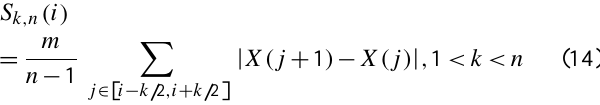
Figure 2. (a) A synthetic nhBm s(z) corresponding to a simulated multi-layer geological6 model. (b) Local changes of the Hurst parameter H(z) obtained by PA.7 Blue: theoretical H values, Red: calculated H values and Grey: layer limits.8